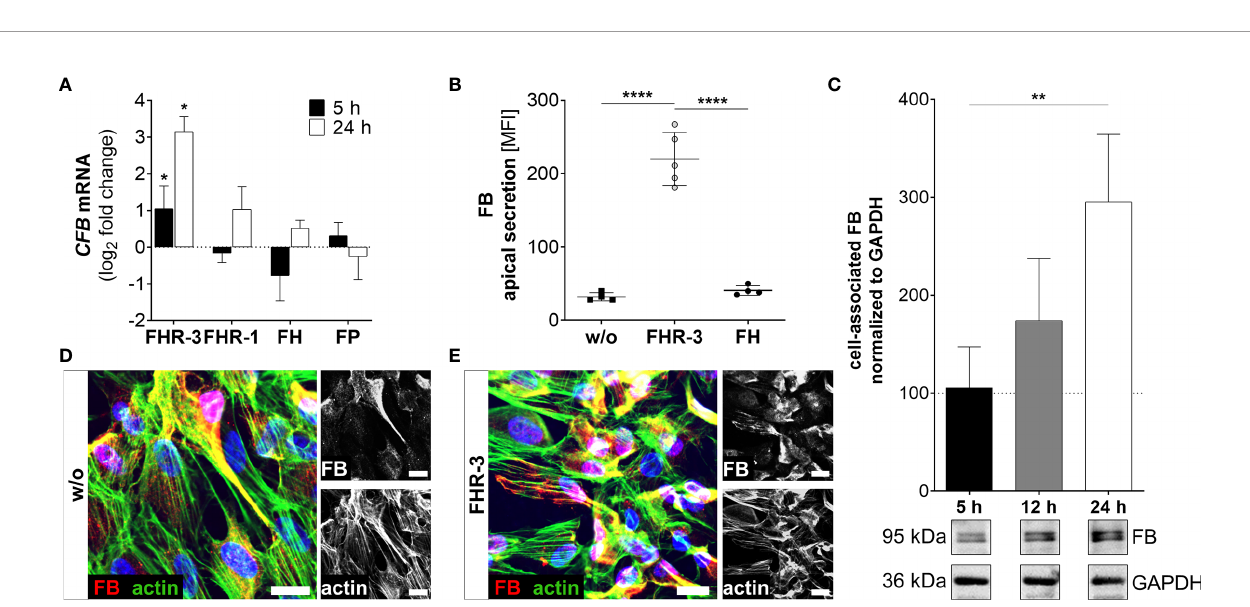
FIGURE 5 | FHR-3 increased FB expression and secretion in ARPE-19 cells. (A) CFB mRNA increased after apical FHR-3 treatment of ARPE-19 cells, but not following incubation with FHR-1, FH or FP. This effect could be con fi rmed at the protein level: (B) Apical FB secretion was increased 24 h after FHR-3 incubation. (C) Western blots of ARPE-19 cell lysates detected a time-dependent increase in FB levels (95 kDa) 24 h after FHR-3 treatment. Supplementary Figure 1L shows full Western blots. (D, E) Increased FB protein levels were detected by immuno fl uorescence using speci fi c anti-FB (red) and anti-actin (green) antibodies 12 h after FHR-3 treatment. FB was co-localized partly with actin stress fi bers (yellow). Scale bars 40 µm. (A – C) w/o untreated control (dotted line). (A – C) Mean with standard deviation is shown. ****p < 0.0001, **p < 0.01, *p < 0.05. (A) Wilcoxon matched-pairs signed rank test (n = 3); (B, C) Ordinary one-way ANOVA, Turkey ’ s multiple comparisons test (n =